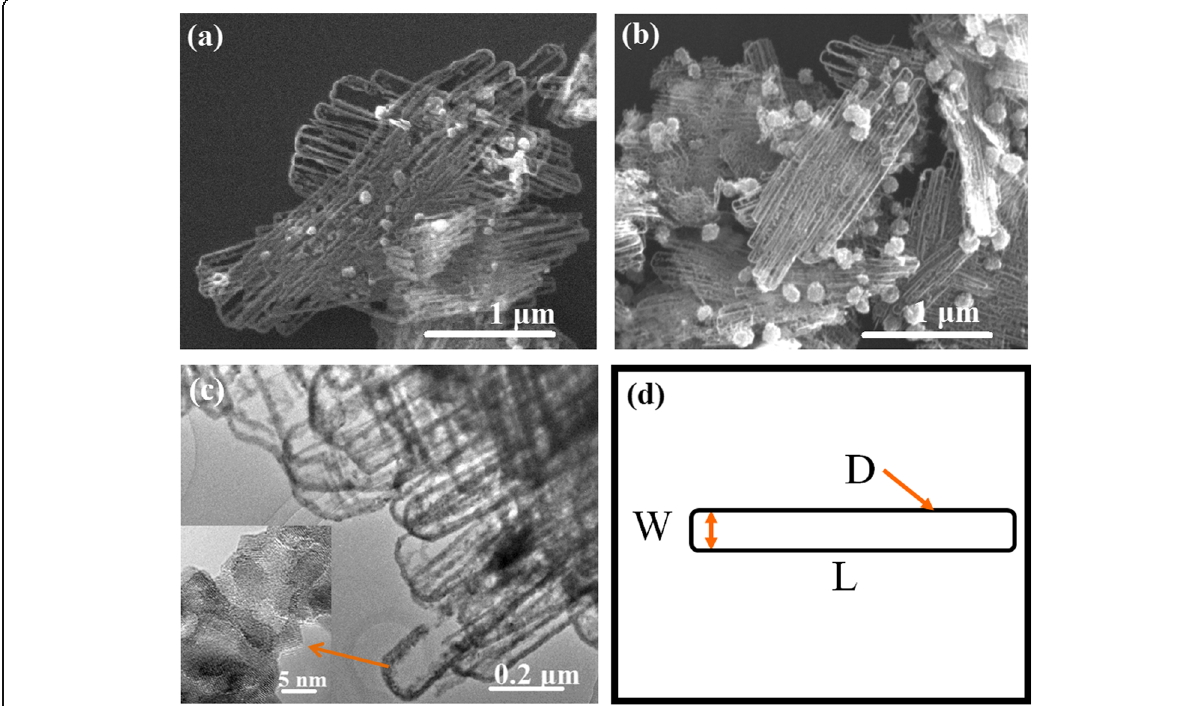
Fig. 1 SEM images of ( a ) as-prepared and ( b ) 600 °C annealed ZnO nano-clip samples. TEM images of ( c ) 400 °C annealed ZnO nano-clips. The insets of ( c ) are corresponding HRTEM images of local magnification. ( d ) Sketch diagram of the ZnO